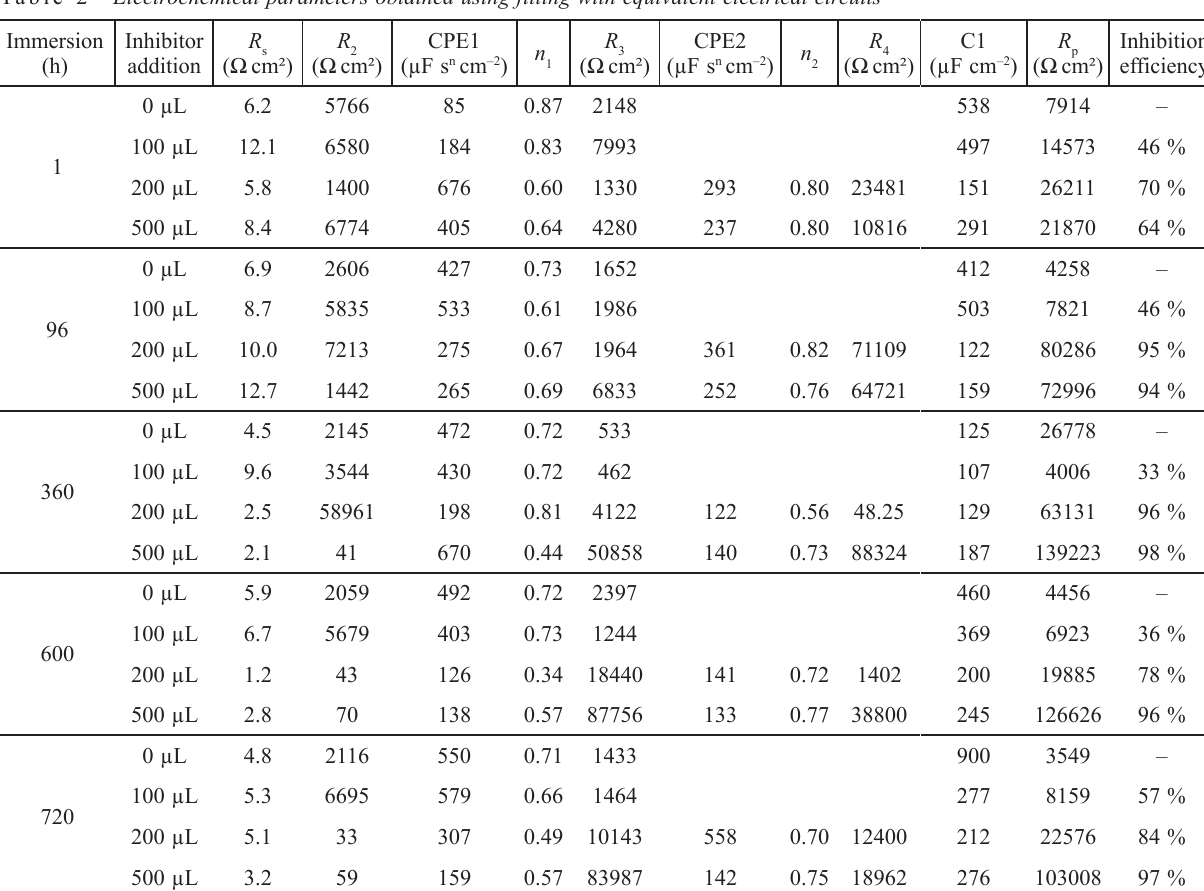
Table 2 – Electrochemical parameters obtained using fitting with equivalent electrical circuits Immersion